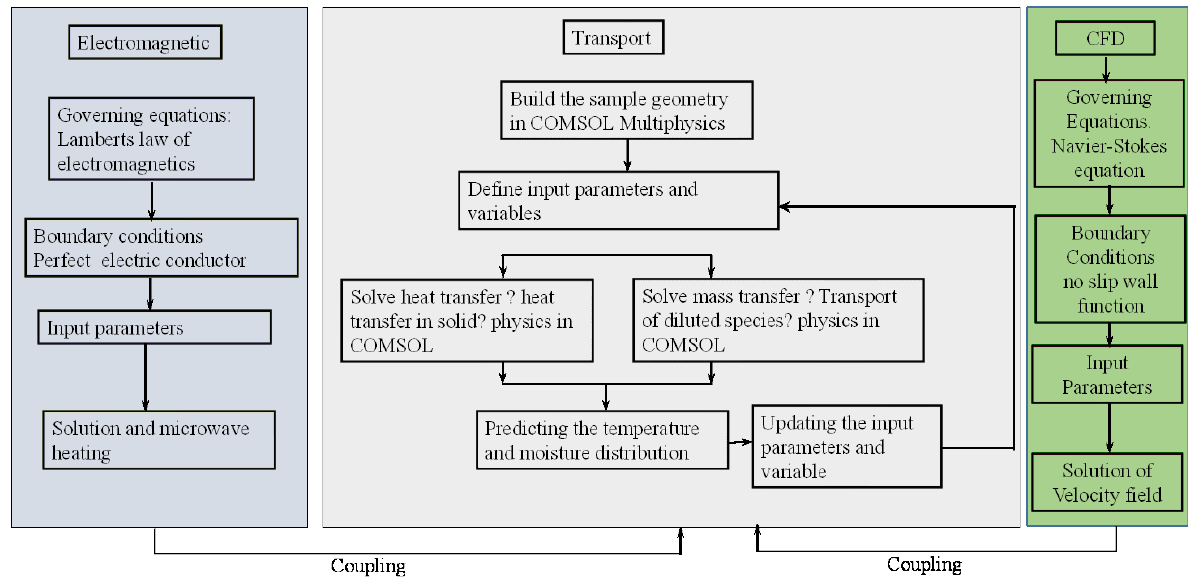
Figure 7. Schematic diagram of different physics that was used to develop a CFD integrated 3D-IMCD model [32].